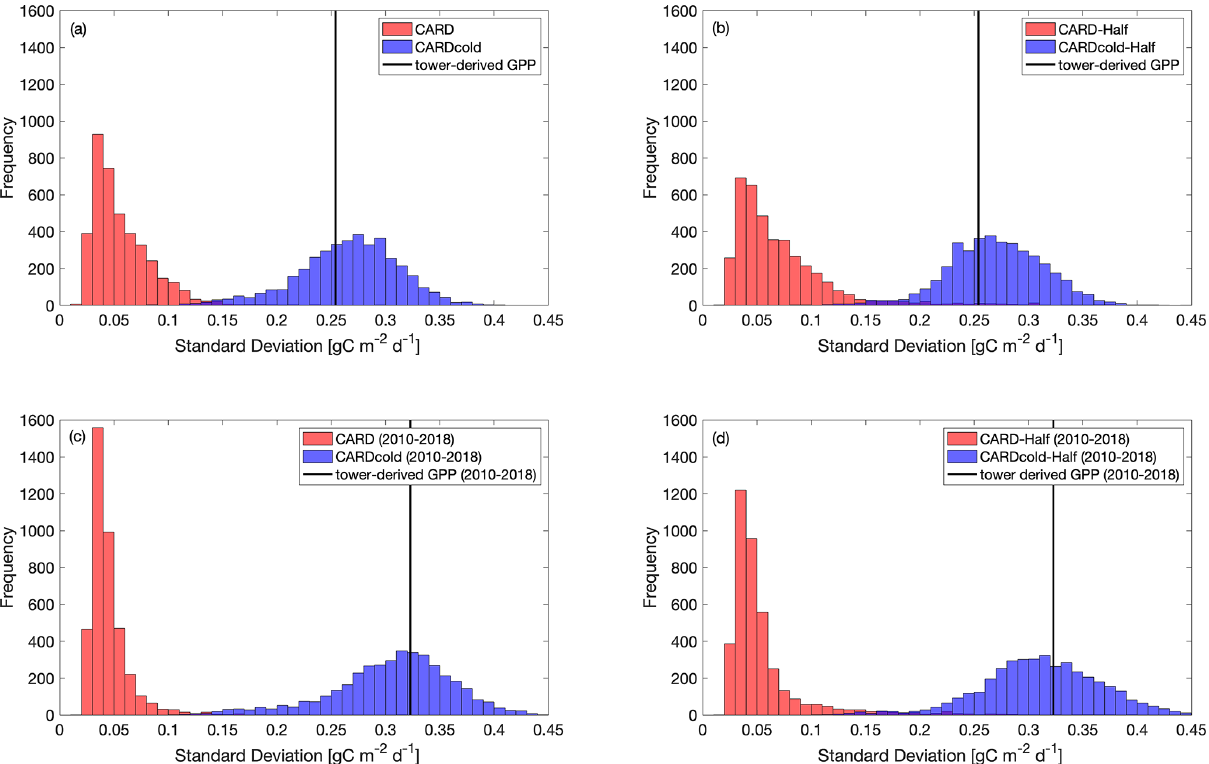
Figure 6. Histograms comparing standard deviation in mean spring GPP across all ensembles ( N = 4000) for CARD (red bars) and CARD- cold (blue bars) experiments with (a) full assimilation, (b) half assimilation, (c) full assimilation for the second decade (2010–2018) and (d) half assimilation for the second decade (2010–2018). The black line indicates the standard deviation in tower-derived mean spring GPP (SD = 0.25gCm − 2 d − 1 for full period (a–b) ; SD = 0.32gCm − 2 d − 1 for 2010–2018 (c–d)